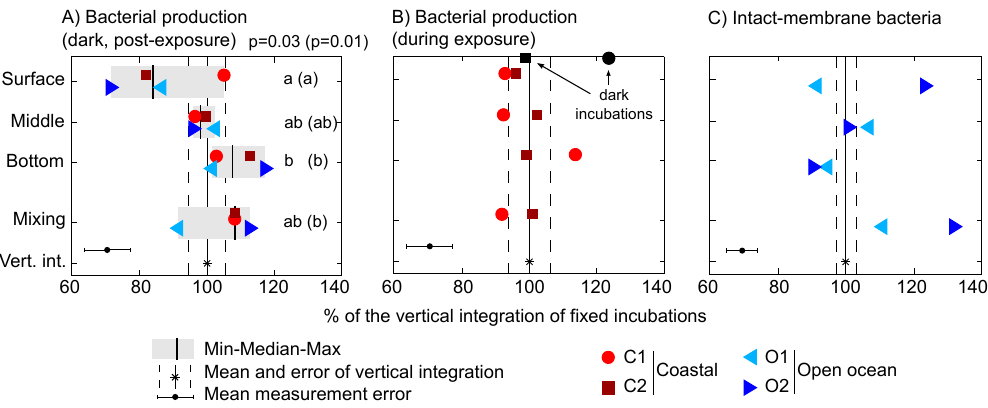
Fig. 5. Response of heterotrophic bacteria to irradiance gradients in static and vertically moving incubations. Leucine incorporation rates in (a) post-exposure dark incubations and (b) in situ light and dark incubations; (c) proportion of intact-membrane (“live”) bacteria as deduced from the nucleic acid double-staining (NADS) protocol. Statistical comparisons as in Fig. 4. In (a) , a test was performed on a subset of experiments (C2, O1 and O2) that exhibited a more coherent response, and the resulting p value and multiple comparisons are shown in parentheses.